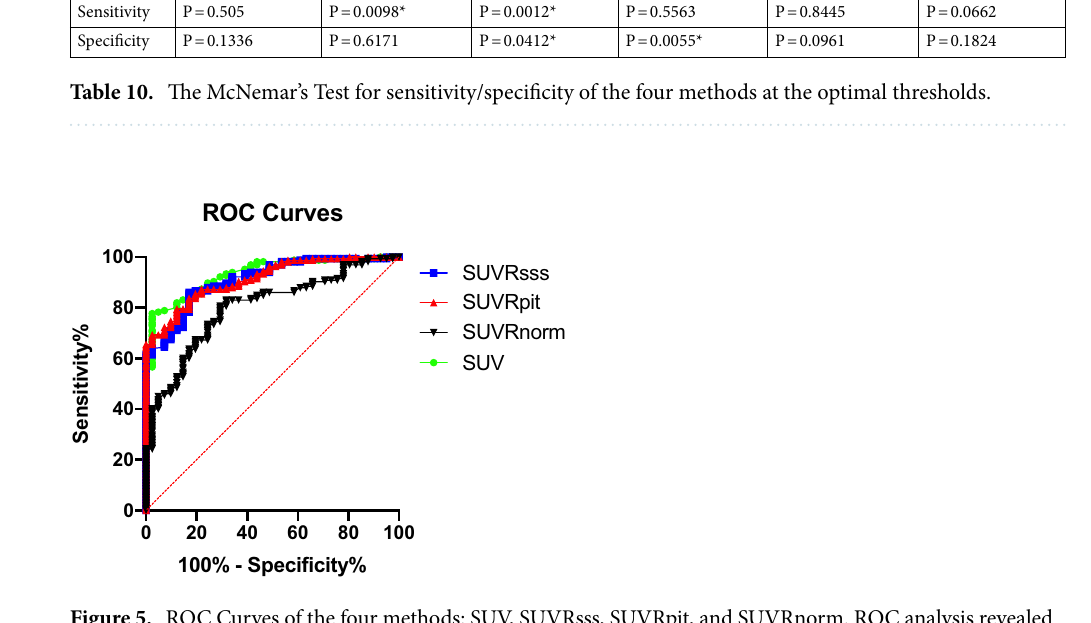
Figure 5. ROC Curves of the four methods: SUV, SUVRsss, SUVRpit, and SUVRnorm. ROC analysis revealed area under the curve of 0.932, 0.910, 0.915, and 0.800 for SUV, SUVRsss, SUVRpit, and SUVRnorm, respectively (all P <